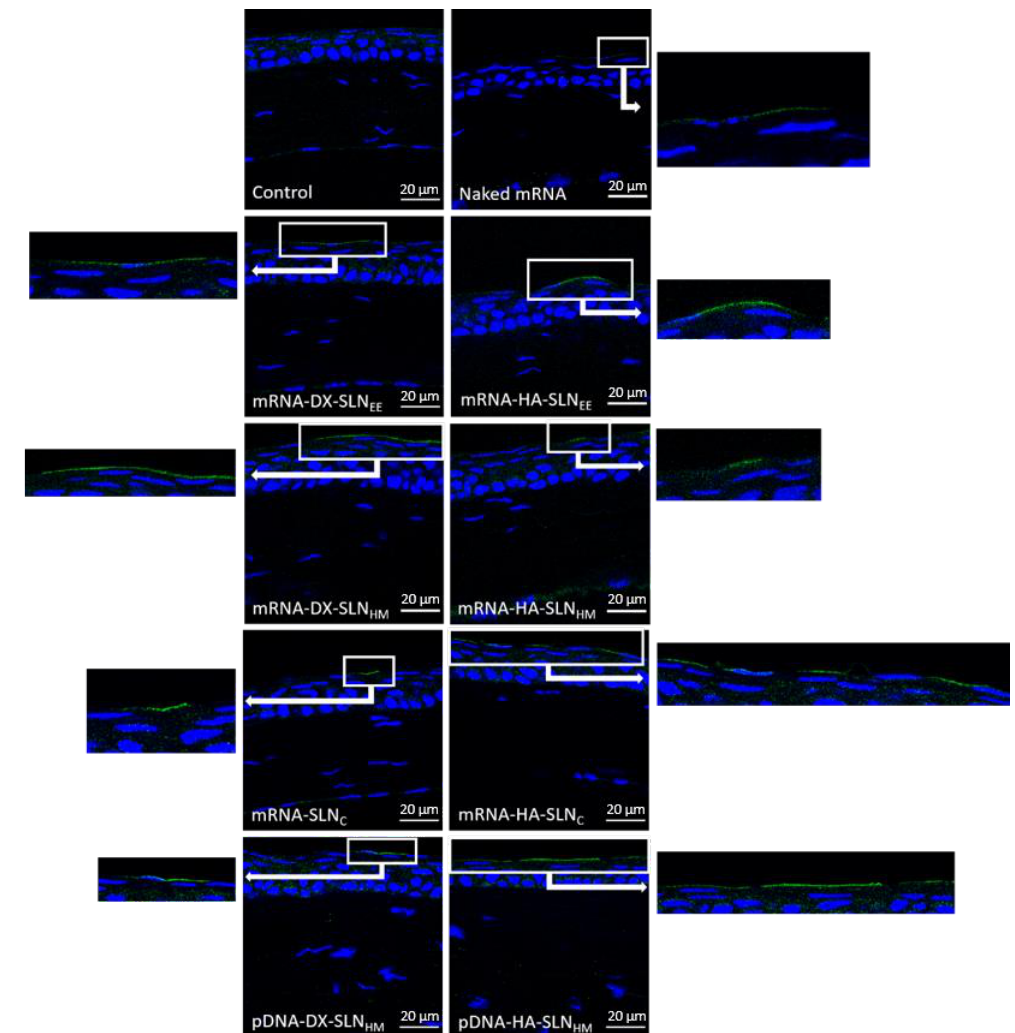
Figure 6. In vivo corneal transfection in mice 48 h after the administration of mRNA- and pDNA-vectors encoding GFP with the viscosifier PVA (63×). Blue: nuclei stained with DAPI. Green: GFP detected by immunofluorescence with the secondary antibody labeled with Alexa Fluor 488. Scale bar: 20 µm. DX: dextran; HA: hyaluronic acid; SLN EE : solid lipid